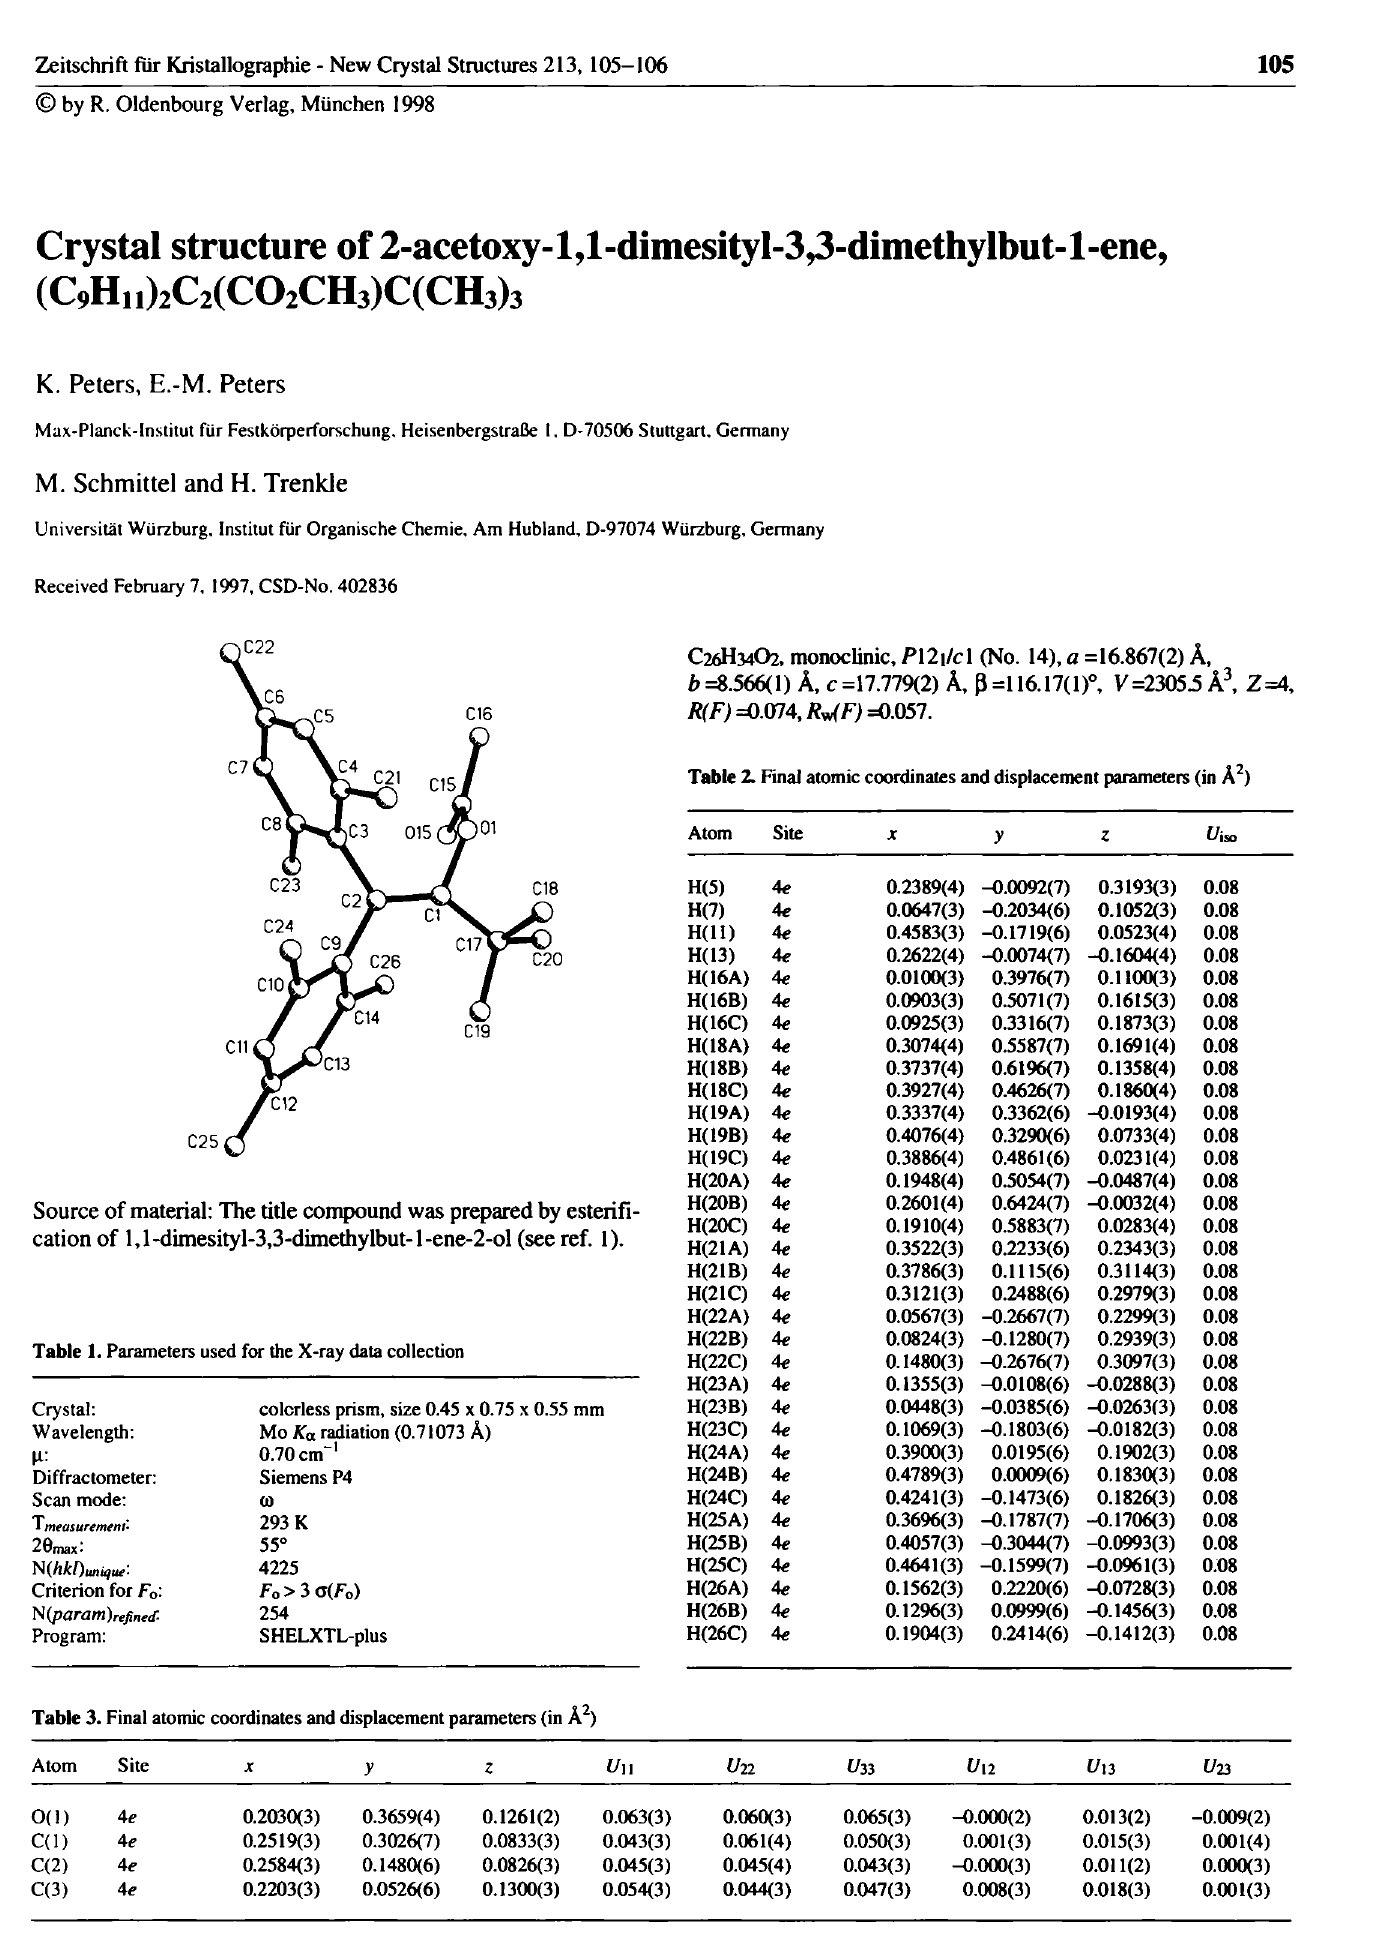
Table 1. Parameters used for the X-ray data collection Crystal: